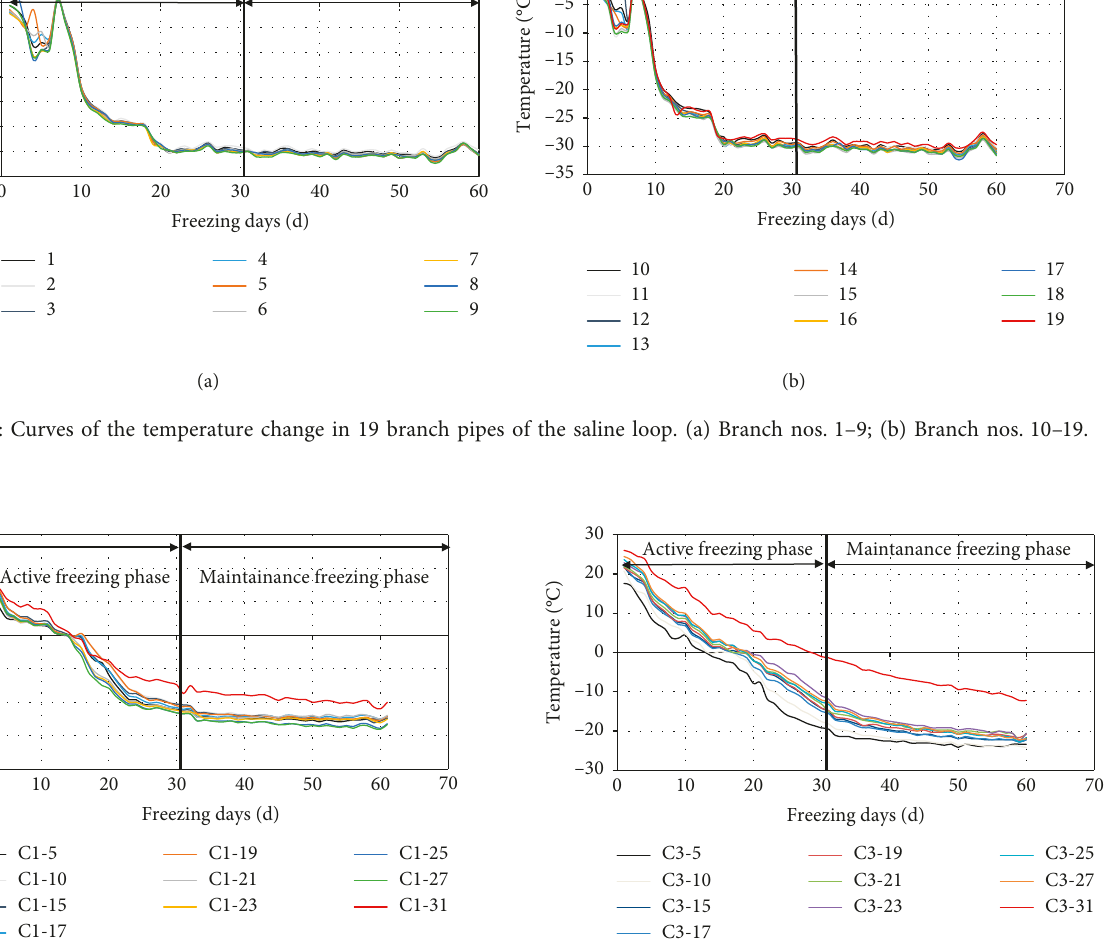
Figure 10: Curves of temperature and times at C3 temperature measuring hole.